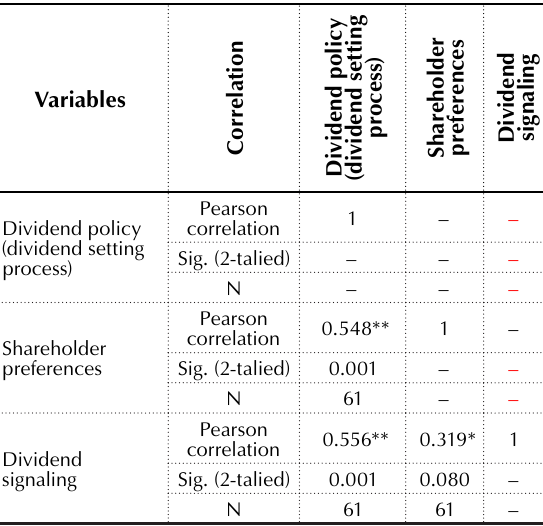
Table 3. Correlations of dividend policy,